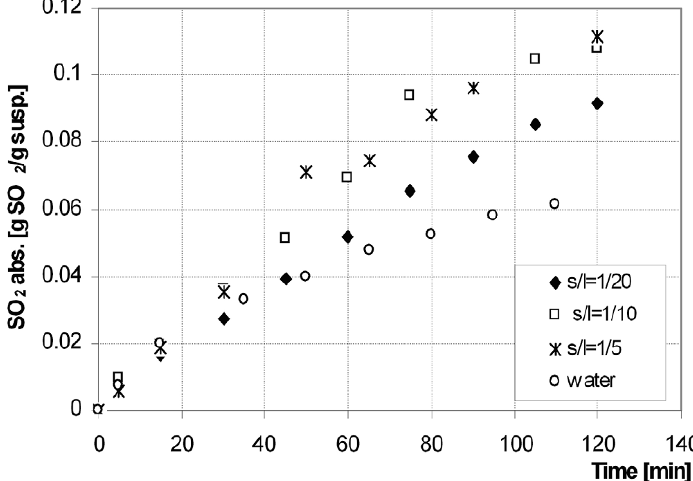
Figure 6. Kinetic data in sulfur dioxide absorption in limestone slurry with dp=0.25 mm and T=298 K.